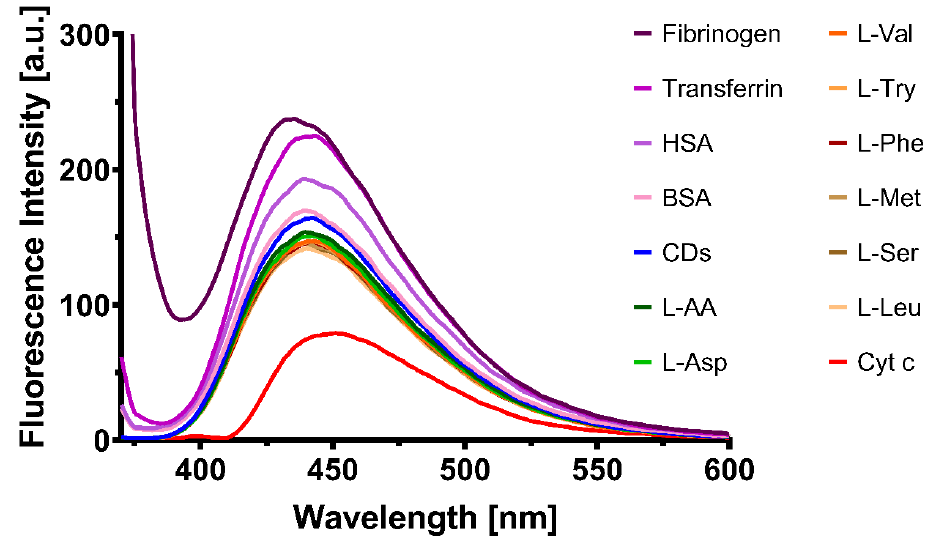
Figure 9. Emission spectra of CQDs in the absence and presence of biological molecules.